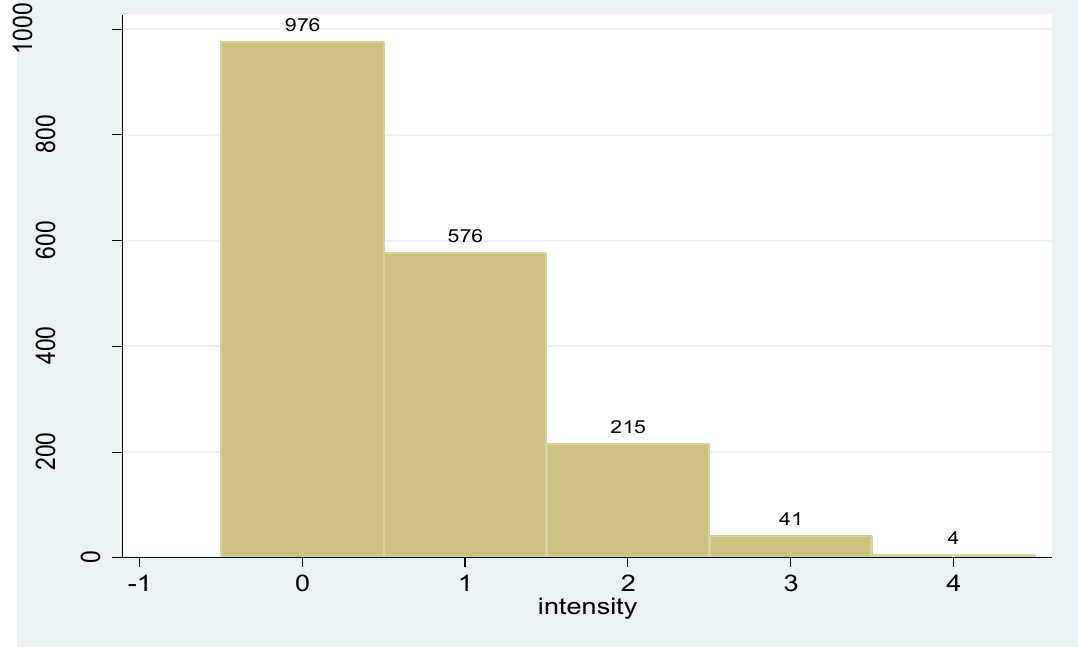
Figure 1. Number of irrigation technologies (intensity) adopted by cotton farmers in the sample of 14 U.S. cotton production states.